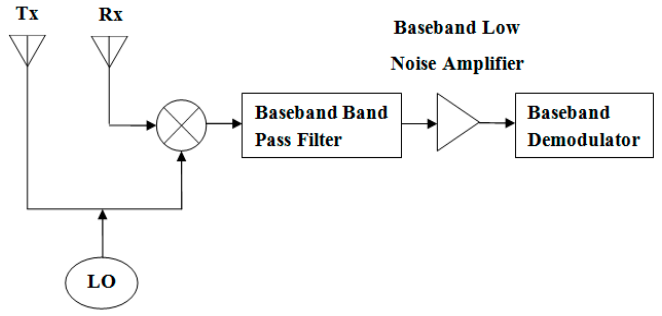
Figure 2. Homodyne transceiver topology.